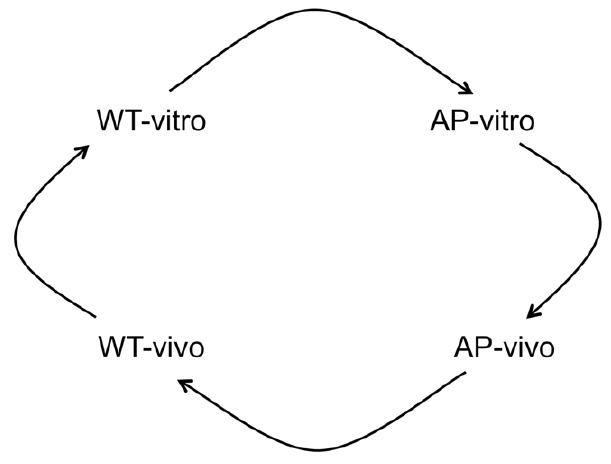
Figure 1. Hybridization scheme. Diagram showing the cyclic hybridization scheme followed in the microarray